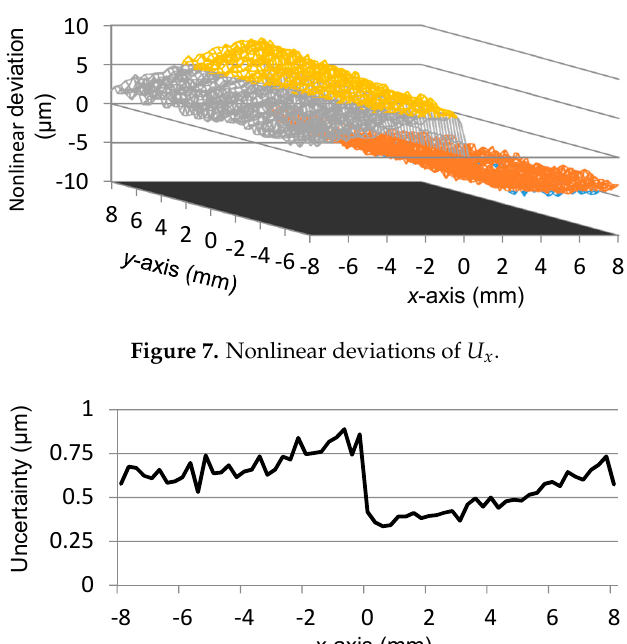
Figure 8. Uncertainty of x -coordinate readings.